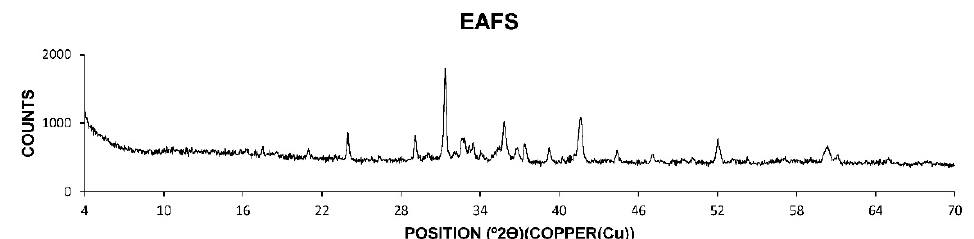
Figure 1. Results of X-ray diffraction of electric arc furnace